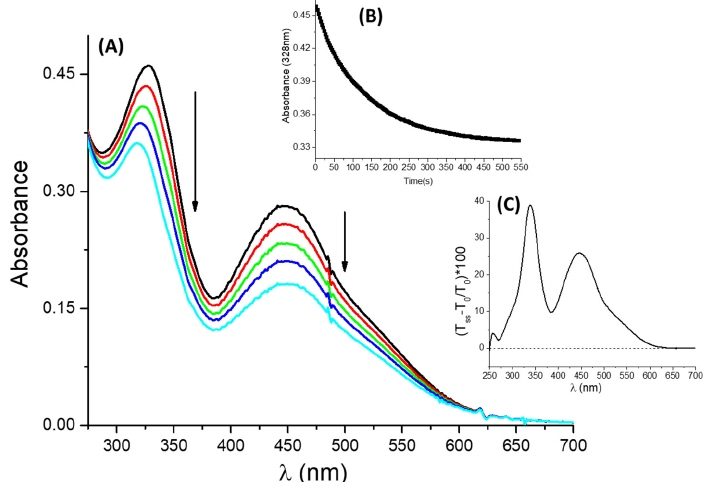
Figure 6. Spectral modifications ( A ) induced by a stationary UV irradiation at λ irr = ( 363 ± 40 ) nm for [ t -DZ ] = 4.8 × 10 − 5 M in [SB3-14] = 0.1 M: the arrows indicate the trends of absorbance in the different spectral regions (the black and cyan traces are the initial and final spectra, recorded before irradiation and at the photo-stationary state, respectively). Graph ( B ) shows how the absorbance at 328 nm changes upon UV irradiation. Graph ( C ) reports the trend of the relative percentage transmittance change, defined in Equation (3), as the function of wavelength.